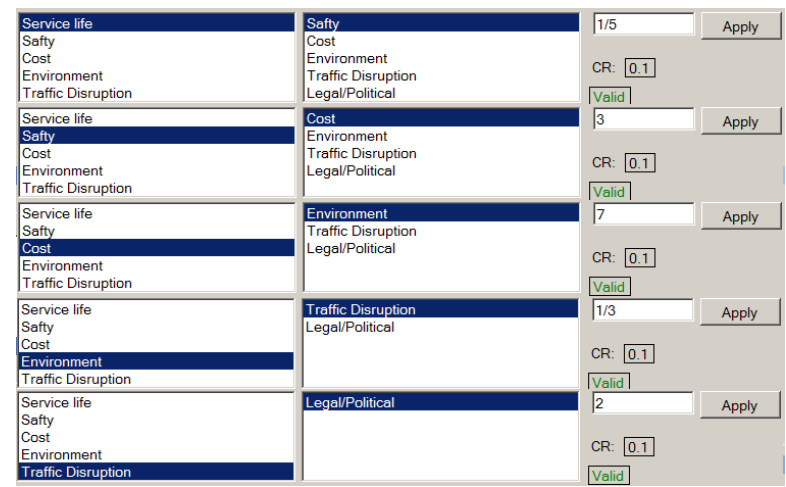
Figure 8. Pairwise Comparison of the Major Criteria in the Developed DSS.